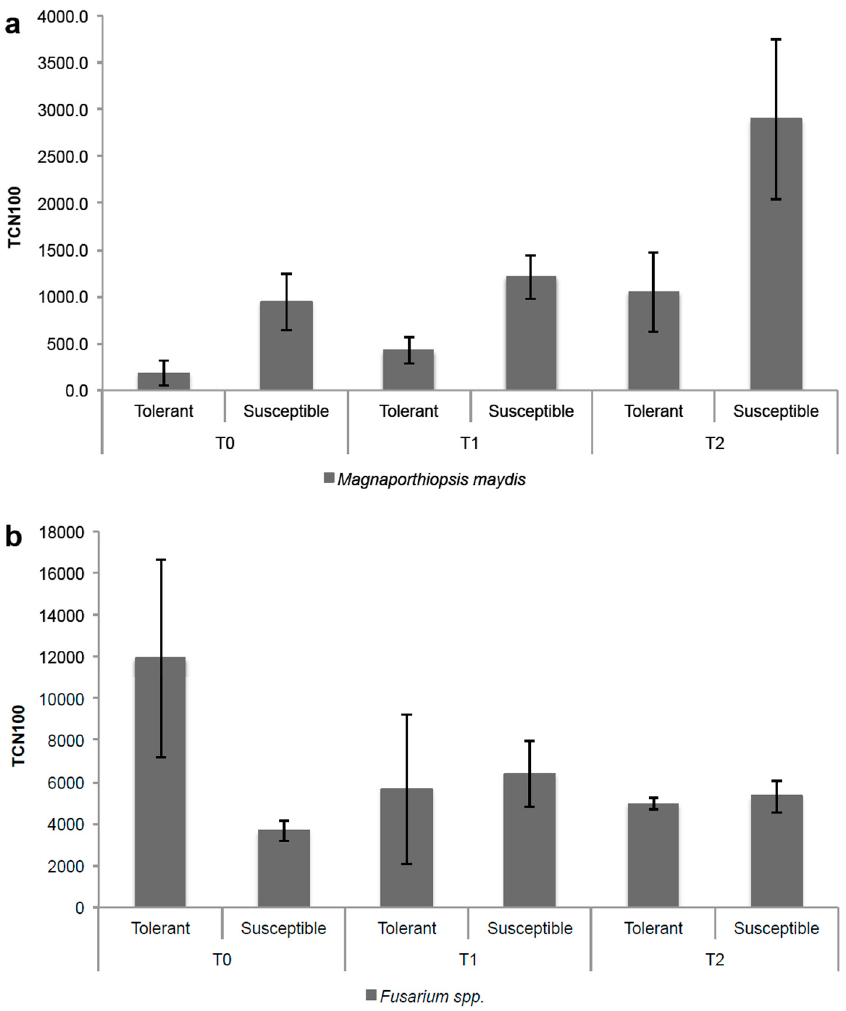
Figure 1. qPCR assay based on Magnaporthiopsis maydis ( a ) and Fusarium spp. ( b ) ITS region applied to a maize field trial. Cultivars were considered tolerant or susceptible to M. maydis . TCN100: target copy number using 100 ng of gDNA. T0: 2 weeks after germination; T1: 4 weeks after germination; T2: 6 weeks after germination.